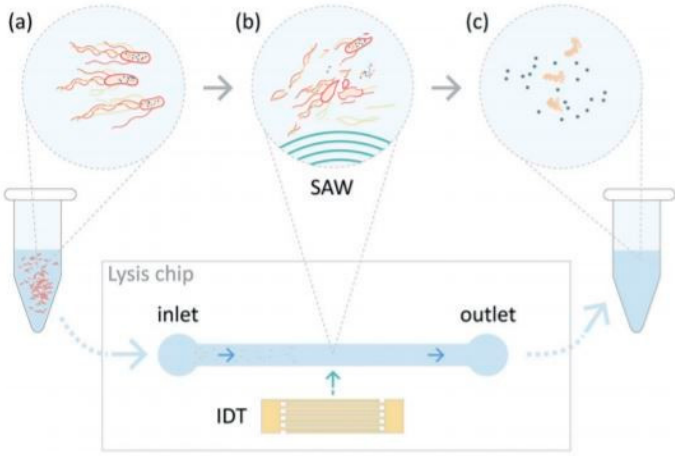
Figure 27. Overview of the TSAW lysis device utilized in [104]. The lysis chip consists of a PDMS microchannel plasma-bonded to a lithium niobate (LiNbO3) substrate with an interdigitated transducer (IDT) adjacent to the microchannel to generate traveling surface acoustic waves. Bacteria suspension was flown through the microchannel ( a ) the bacteria suspension was exposed to a TSAW field ( b ) and the lysate for further analysis were collected ( c ). Adapted with permission from [104]. Copyright 2019 Royal Society of Chemistry.